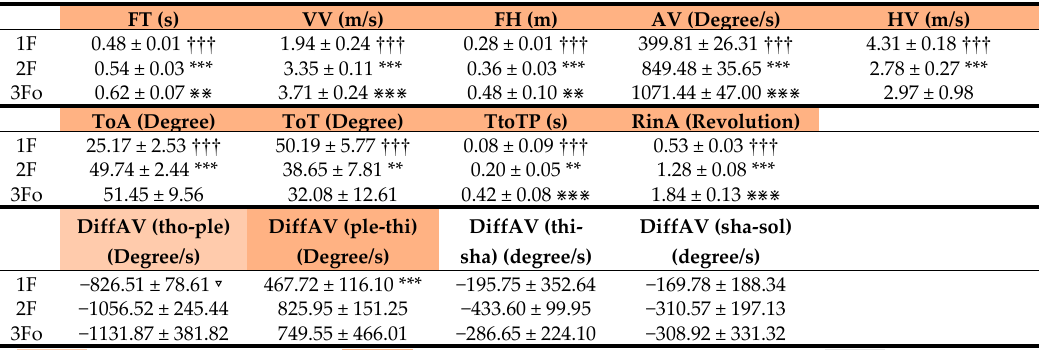
Table 1. Kinematic parameters for 1F, 2F and 3Fo (Mean ± Standard deviation). parameters highlighted were found significant different among 1F, 2F and 3Fo (see definition of 1F, 2F and 3Fo in Section 2.2; see definition of all thirteen kinematic parameters in Section